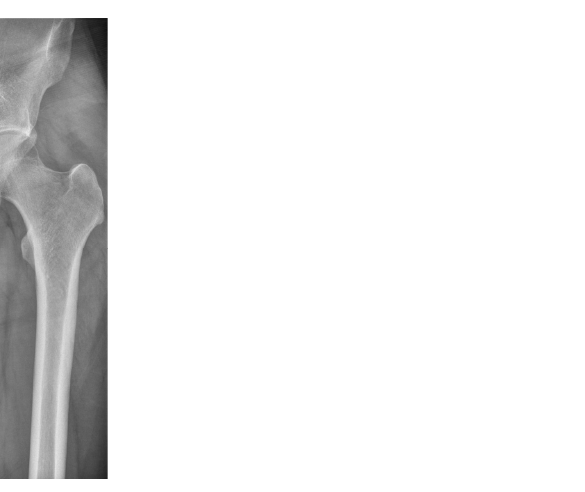
Figure 2. Conventional radiography was performed 4 months after the final operation. The white arrow indicates an incomplete transverse fracture in the lateral cortex of the right femur.